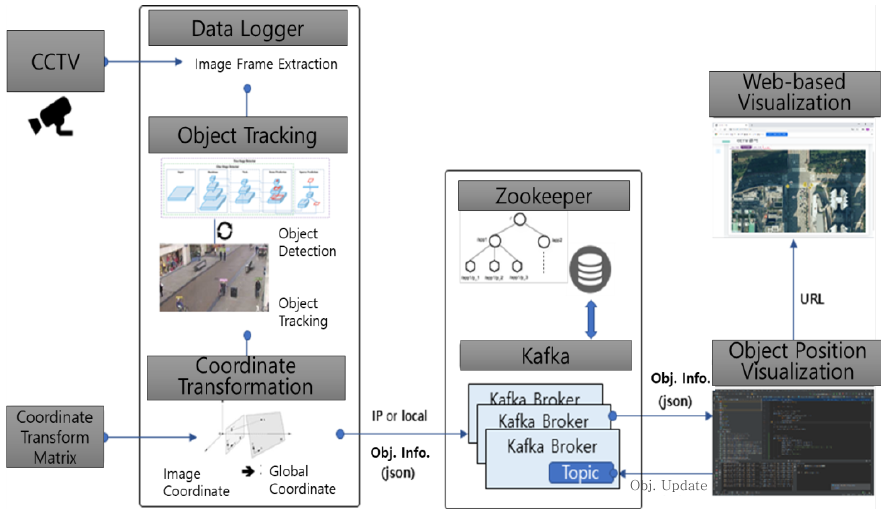
Figure 2. Overview of the implemented system.